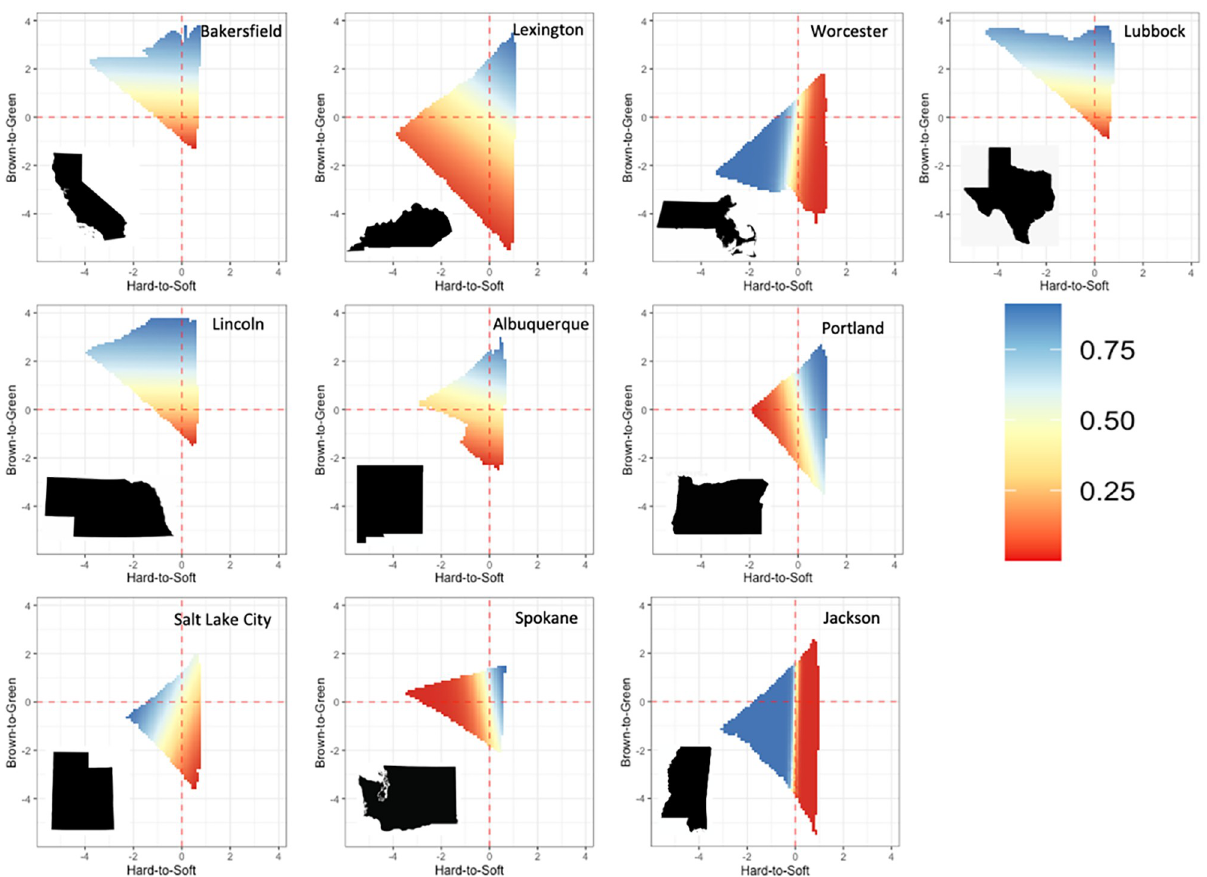
Fig 4. Predicted robin occupancy along dual landscape gradients: Surface plots depicting robin occupancy on both the brown-to-green (y axis) and hard-to-soft (x axis) for each of the ten cities. The color scale ranges from low occupancy (red) to high occupancy (blue). Variation in surface plots highlights the differences in landscape composition in study cities, and the variable response to urbanization along the hard-to-soft gradient.